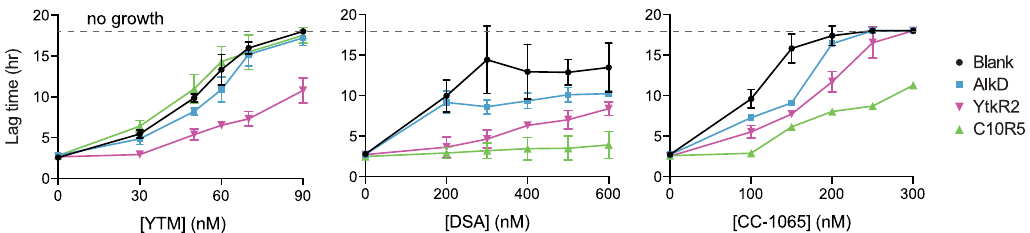
Fig. 3 Determination of drug resistance. E. coli BL21(DE3) cells transformed with either an empty plasmid (blank) or a plasmid encoding AlkD, YtkR2, or C10R5 were grown in the presence of various concentrations of YTM, DSA, or CC-1065. A shorter lag phase (lag time) before the onset of exponential growth indicates increased drug resistance. A complete lack of cell growth was plotted as a lag time of 18 h, the total incubation period for the cultures, as indicated by the dashed line. Data are presented as the mean ± SD from four replicate experiments. Source data are provided as a Source Data fi